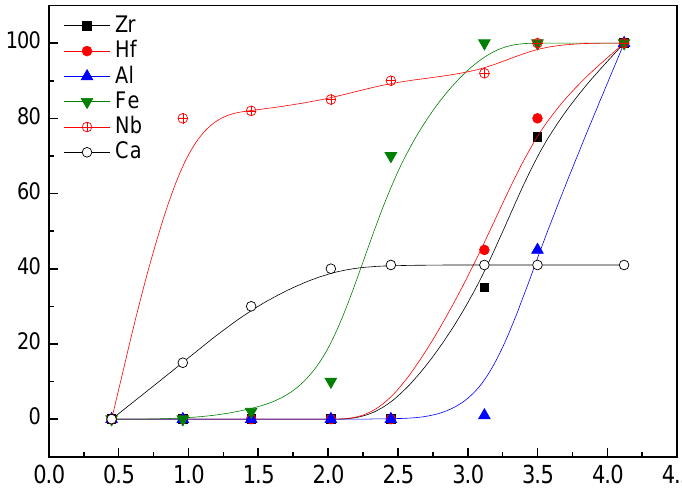
Figure 4. E ff ect of pH on the precipitation of elements from the leach Figure 4. Effect of pH on the precipitation of elements from the leach solution.